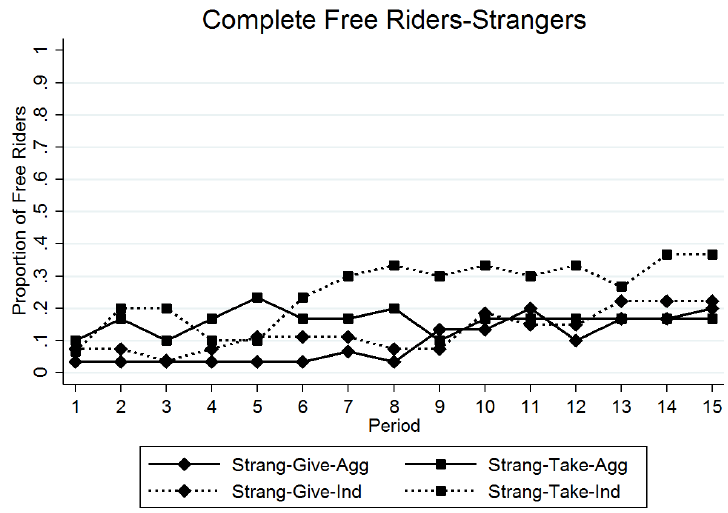
Figure 5. Proportion of Free Riders Over Time